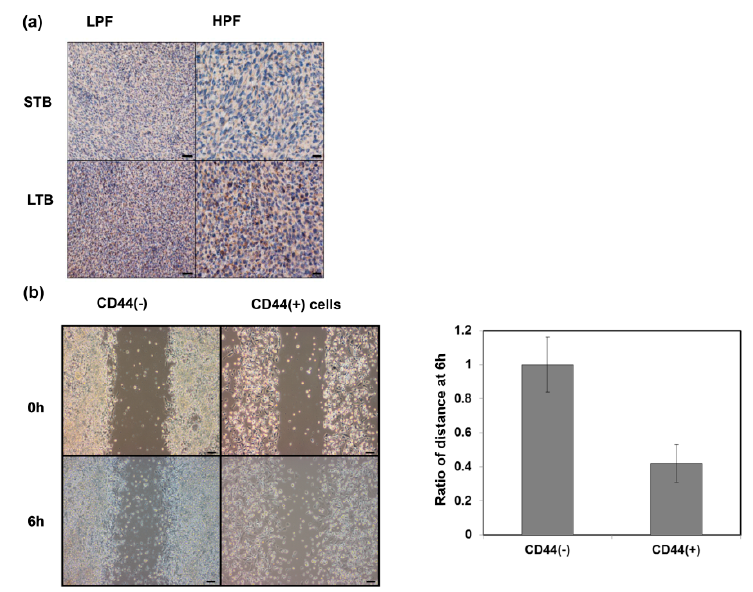
Figure A2. Role of CD44 in tumor aggressiveness. ( a ) The levels of CD44 were evaluated by IHC using ectopic tumors of LTB and STB. Scale bars: 50 µm (left panel); 20 µm (right panel) ( b ) The invasive capacity was evaluated using migration scratching assay in vitro. The representative slides and quantitative data are shown. Scale bars: 50 µm.